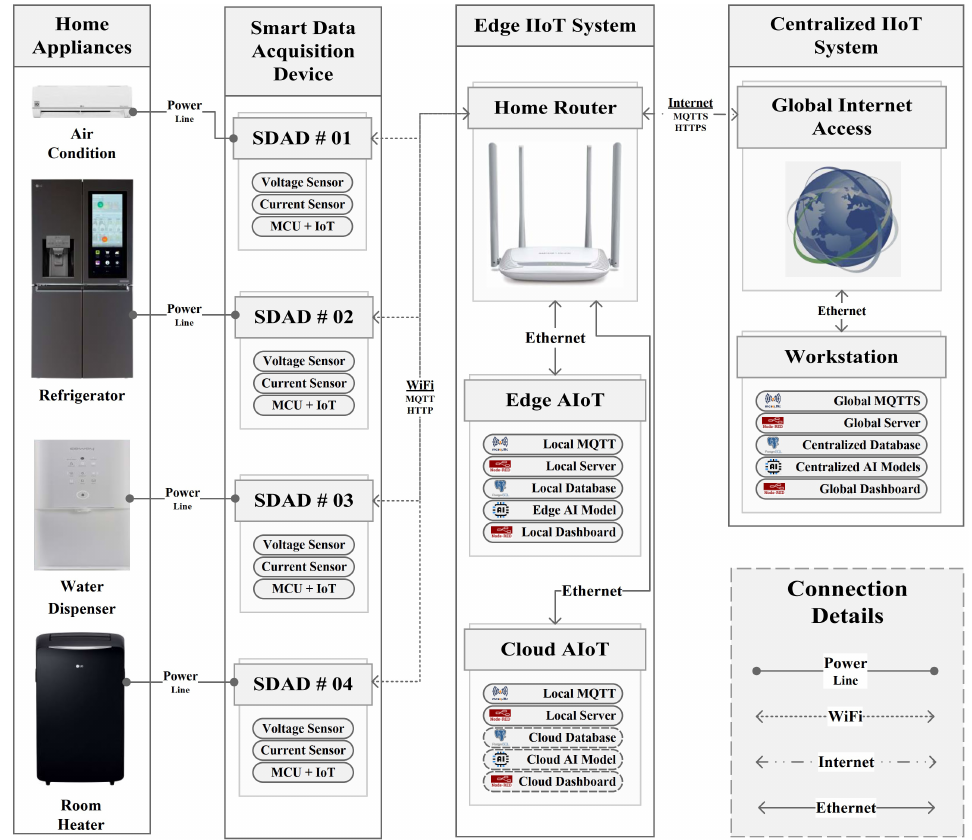
Figure 1. Proposed system